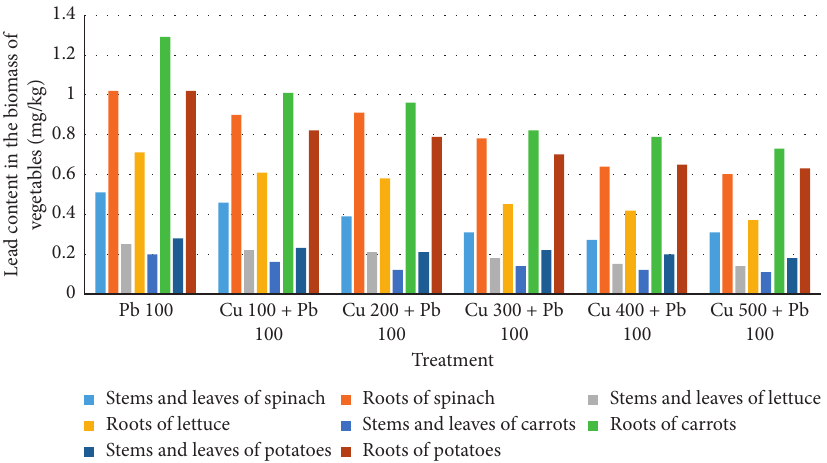
Figure 2: Effect of copper on the accumulation of lead from soil on the biomass of the studied Table 9: Effect of zinc on the accumulation of lead from soil of leafy vegetables.